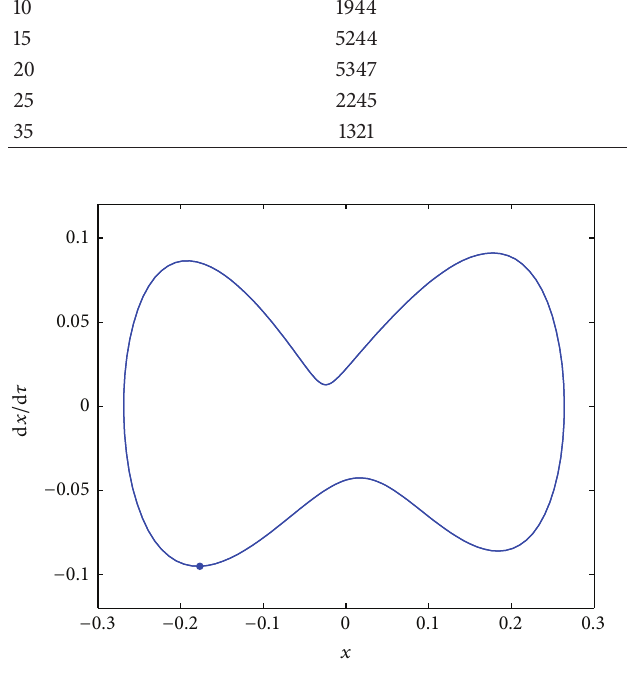
Figure 12: Phase plot and Poincar´e section for 𝑍 𝑒 = 2.02𝑔 .